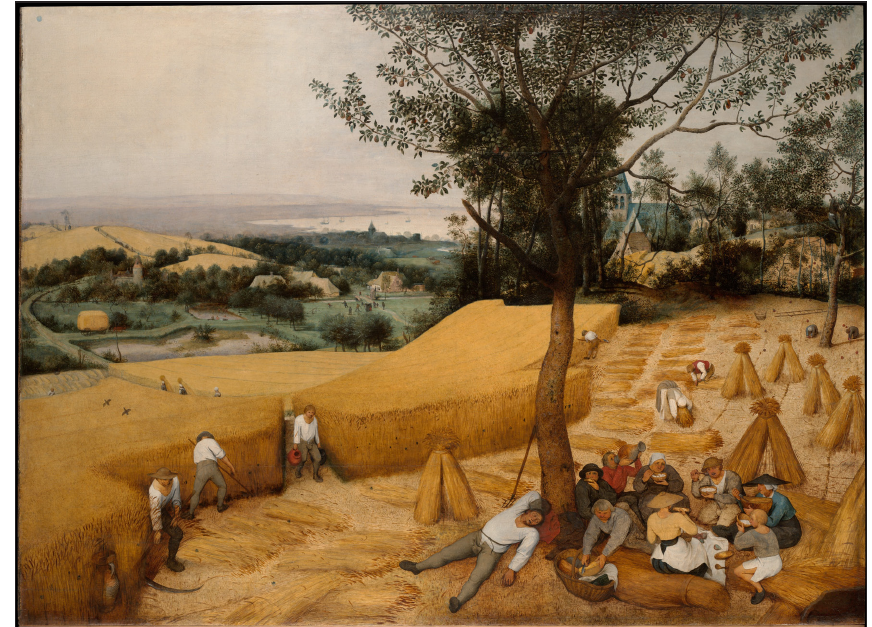
Figure 1: Pieter Bruegel, The Harvesters , 1565, New York, Metropolitan Museum of Art (19.164). (Photo: Licensed under CC0 1.0 Universal Public Domain